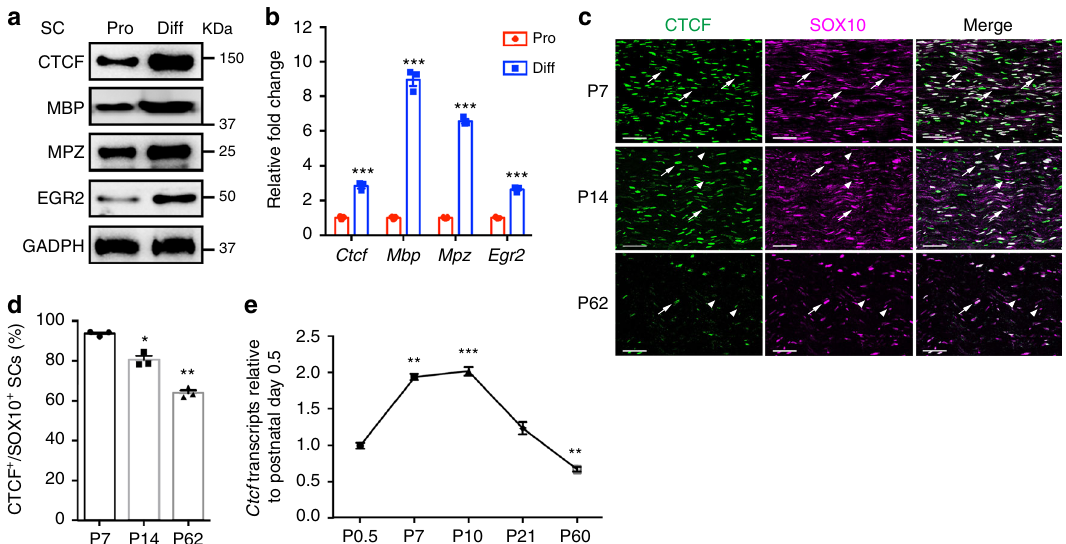
Fig. 1 CTCF expression changes during SC-lineage progression. a Western blots for CTCF, MBP, MPZ, and EGR2 in proliferating and differentiated rat SC cultures. GAPDH served as a loading control. n = 2 independent experiments. b Relative qPCR expression of Ctcf , Mbp , Mpz , and Egr2 in proliferating and differentiated rat SC cultures. Data are presented as means ± SEM., *** P < 0.001, n = 3 independent experiments; two-tailed unpaired Student ’ s t -test, P ( Ctcf) = 0.00021, P ( Mbp) = 2.8E-05, P ( Mpz) = 1.7E-06, P ( Egr2) = 3.9E-05. c Colocalization of CTCF with SOX10 in SC nuclei from mice at P7, P14, and P62 evaluated by immuno fl uorescence labeling. Representative images are shown. n = 3 nerve tissues at each time point. Arrows indicate SOX10 + /CTCF + SCs; arrowheads indicate SOX10 + /CTCF − SCs. Scale bars: 50 μ m. d The percentage of CTCF + nuclei in SCs (SOX10 + ) in sciatic nerves from P7, P14, and P62 mice. n = 3 control tissues at each time point. Data are presented as means ± SEM., * P < 0.05, ** P < 0.01; n = 3 nerve tissues at each time point; one- way ANOVA with multiple comparisons test. P (P14) = 0.0392, P (P62) = 0.0052. e Relative qPCR expression of Ctcf in mouse sciatic nerves at various developmental stages. Data are presented as means ± SEM., ** P < 0.01, *** P < 0.001; n = 3 nerve tissues at each time point; one-way ANOVA with multiple comparisons test, P (P7) = 0.0067, P (P10) = 0.0004, P (P21) = 0.1503, P (P60) = 0.0077. Source data are provided as a Source Data fi